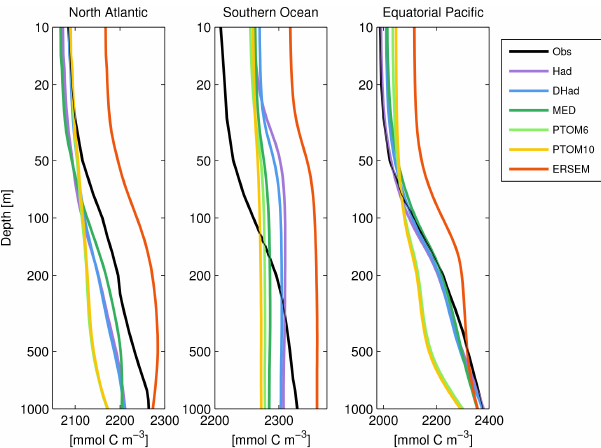
Figure 7. Observed (black; GLODAP) and modelled profiles of alkalinity (meqm − 3 ) in the north Atlantic (0 to 60 ◦ N), Southern Ocean (90 to 60 ◦ S) and equatorial Pacific (15 ◦ S to 15 ◦ N). Verti- cal scaling is logarithmic (log 10 )